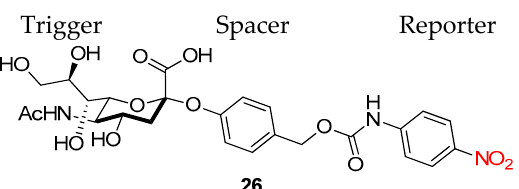
Figure 5. Chemical structure of the prodrug neuraminidase substrate 26 . After the neuraminidase-based enzymatic removal of the Neu5Ac residue, a sequen- tial 1,6-elimination and decarboxylation reaction resulted in the release of the 4-nitroan- iline reporter and para -quinone methide (Scheme 29).